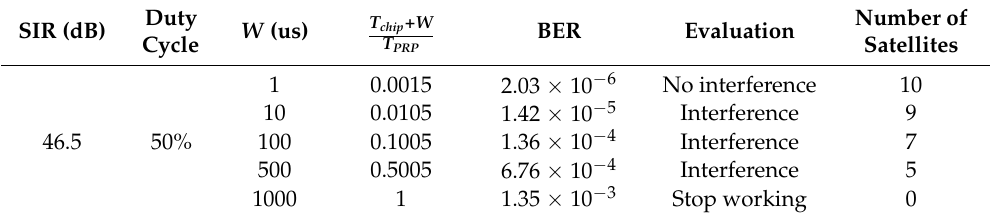
Table 1. EMC evaluation experiment results of BDS when changing pulse width.